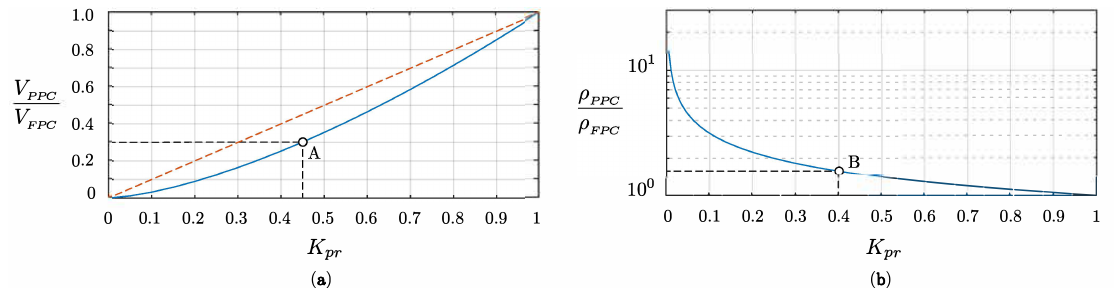
Figure 4. Volume of the dc–dc converter. ( a ) Working with a full power converter; ( b ) Working with a partial power